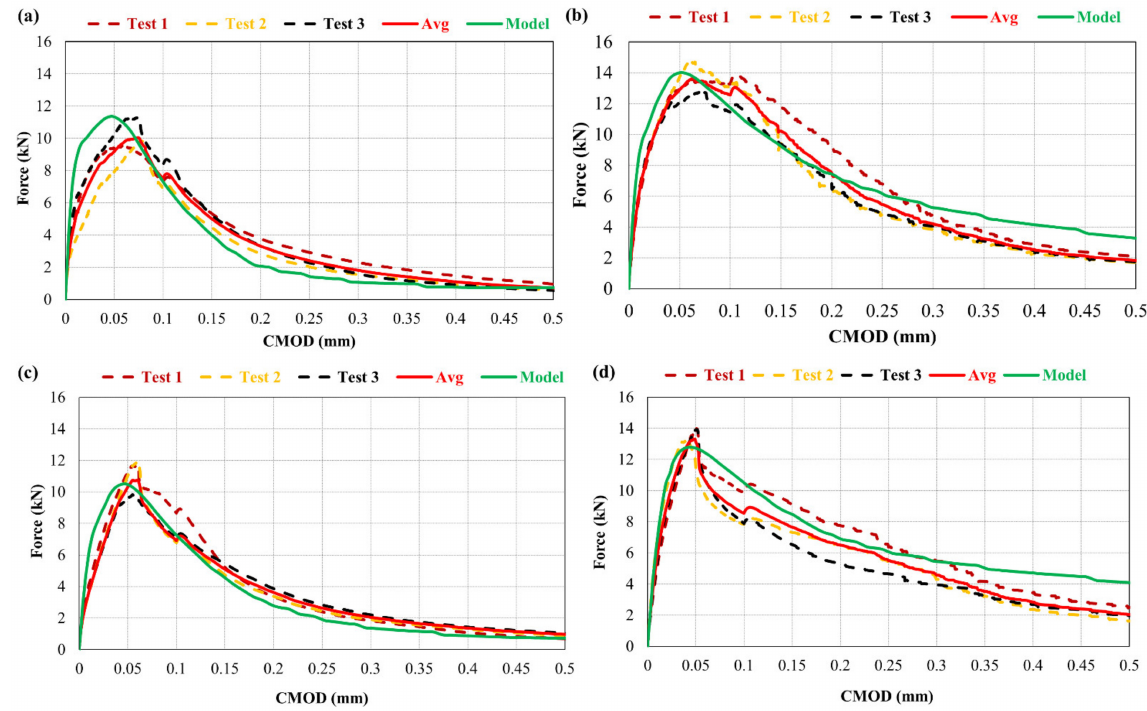
Figure 16. Force vs. opening of notch (CMOD) for ( a ) M0R0F-M0R0F, ( b ) M0R0F-M0R30F, ( c ) M0R0F- M30R0F, and ( d )